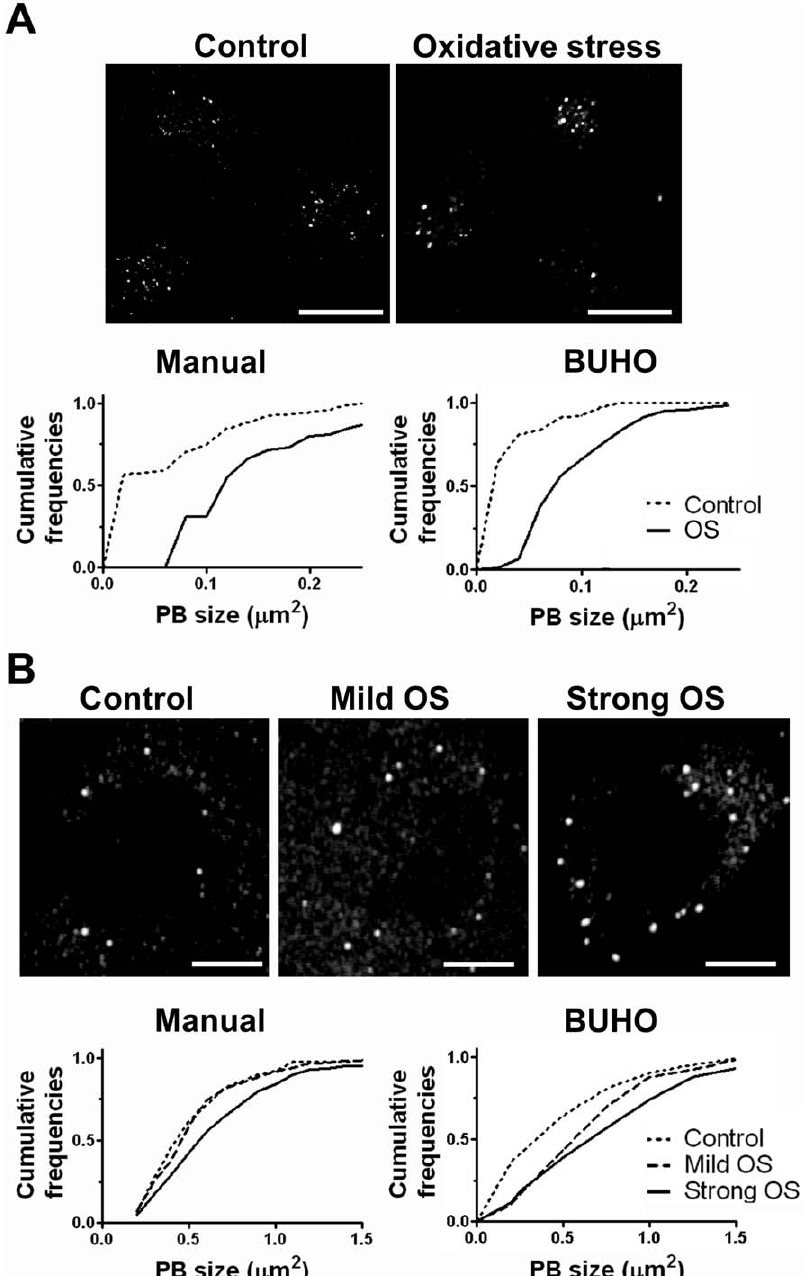
Figure 3. Analysis of PB induction by BUHO. Fly (A) or mammalian cells (B) were exposed to oxidative stress as indicated in Materials and Methods and PBs were immunostained. PB size was evaluated using BUHO in 55 resting and 68 stressed S2R + cells, and in 15 resting and 23 stressed U2OS cells, and by manual counting in 10 stressed or 10 resting S2R + representative cells and 9 stressed and 9 resting representative U2OS cells. 63 6 , 1024 6 1024 (A) or 40 6 , 2048 6 2048 (B) confocal images were used. Size bar, 10 m